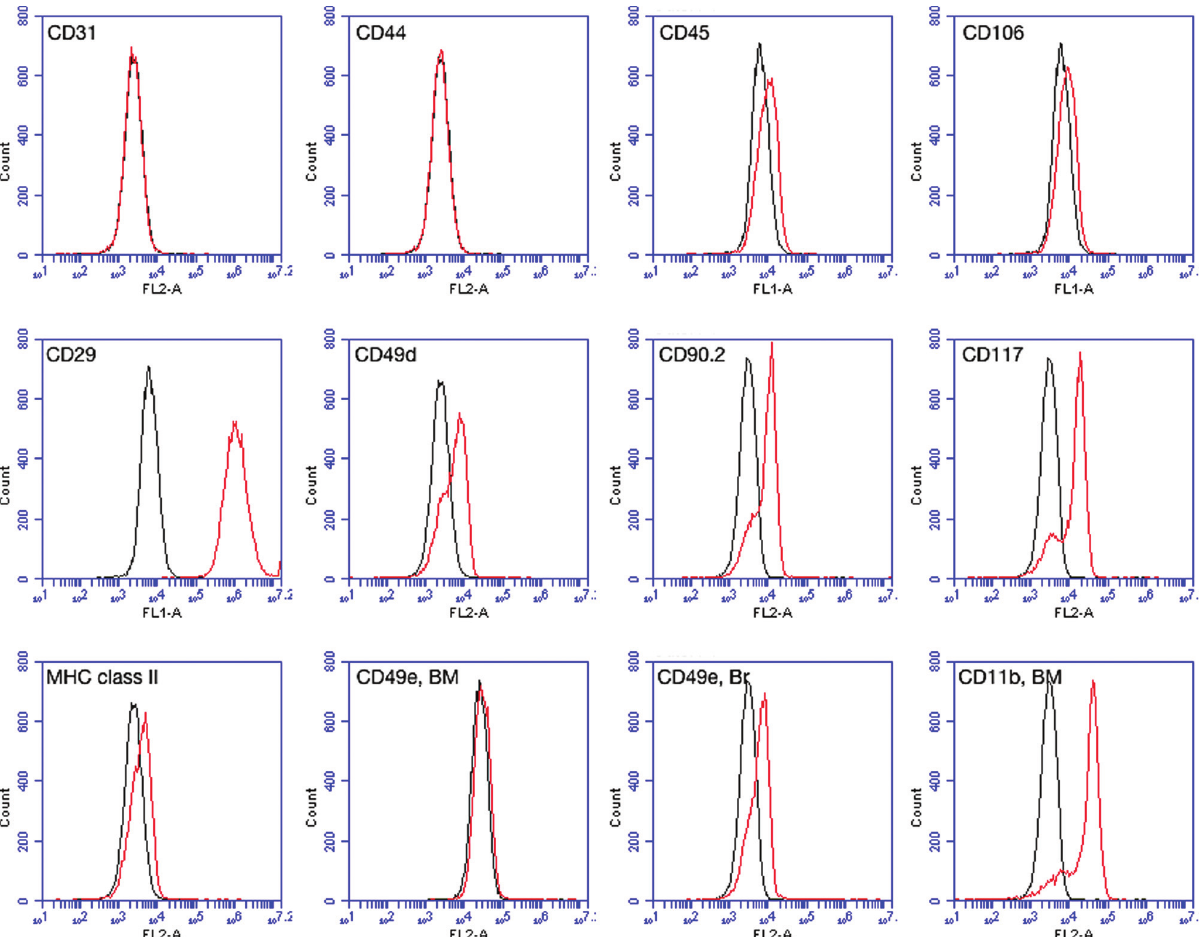
Figure 4 - Immunophenotype of adipose-derived (n = 3) and brain- and bone marrow (BM)-derived (n = 2) MSCs. Representative results show that all cultures were negative for CD31, CD44, CD45, CD106, and MHC class II. Cultures were strongly positive for CD29 and weakly positive for CD49d, CD90.2, and CD117. Adipose- and BM-derived MSCs were negative for CD49e, and brain (Br)-derived cells were weakly positive. Two of the anti-CD11b antibodies tested showed positive marking for Br- and BM-derived